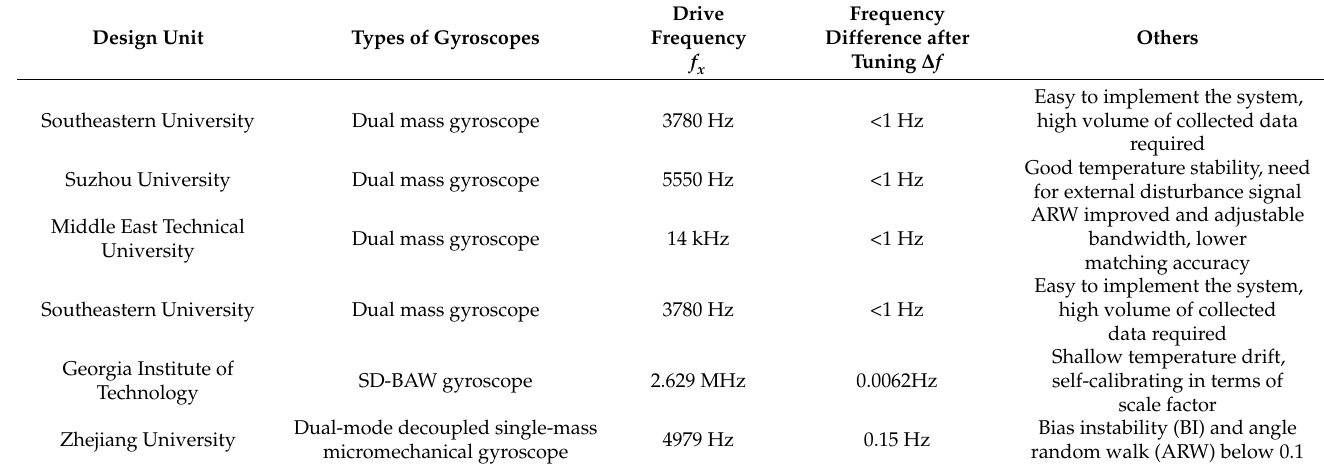
Table 4. Comparison of electrostatic tuning schemes with dual reference to phase and